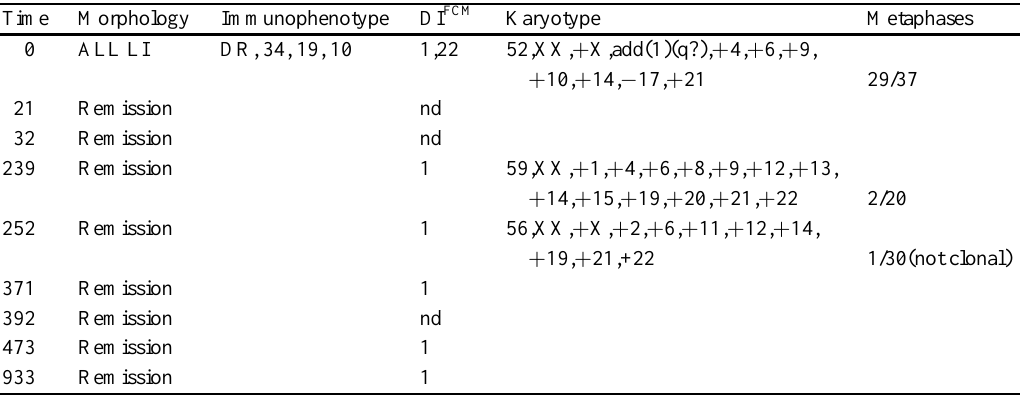
Data from karyotyping and flow cytometric DNA index (DI FCM ) measurements in diagnostic and follow up samples